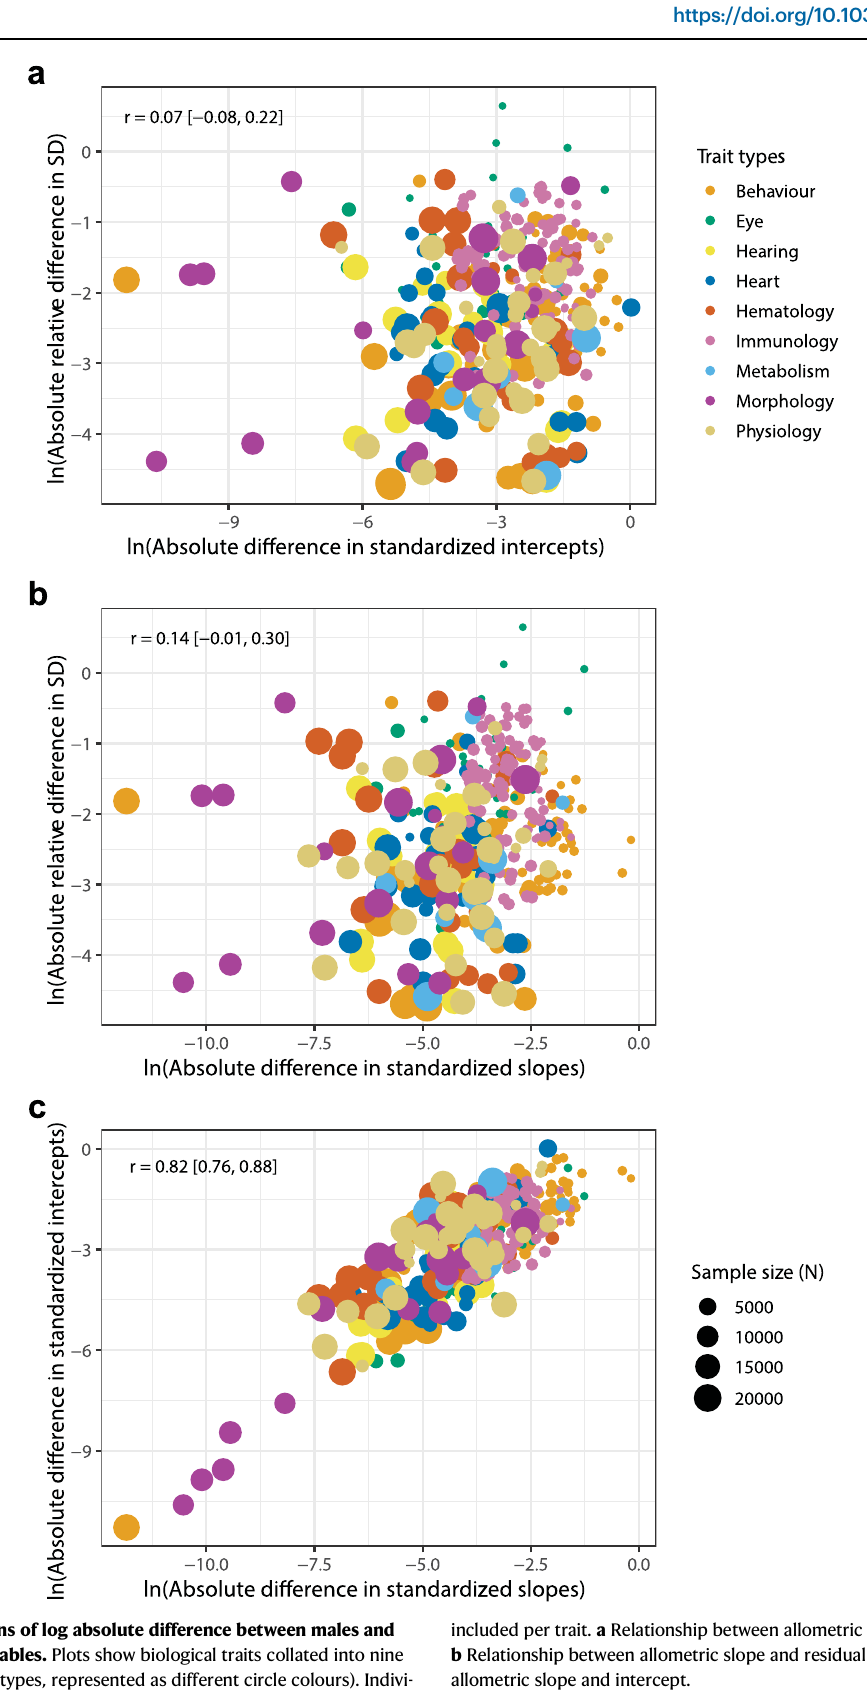
included per trait. a Relationship between allometric intercept and residual SD. b Relationship between allometric slope and residual SD. c Relationship between allometric slope and